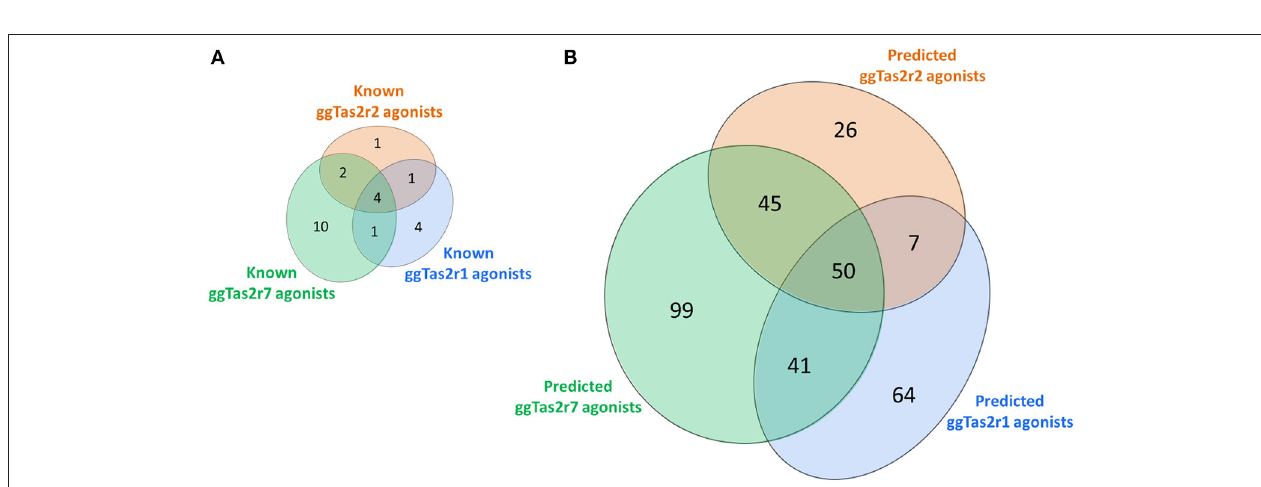
FIGURE 5 | Venn diagrams of known (A) and predicted (B) ggTas2r agonists. The portions of ggTas2r1, − 2, and − 7 agonists are colored in blue, orange and green, respectively.